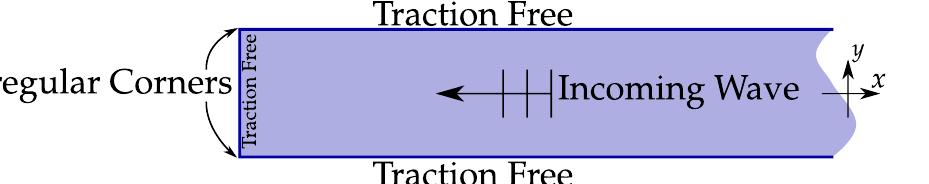
Figure 2. A simple canonical problem, containing two corners with locally irregular behaviour, at the points of intersection of the traction-free surfaces. A propagating symmetric Lamb wave is incoming from the right, and we wish to determine the resulting scattered field. The method we introduce will also work for an incoming asymmetric Lamb